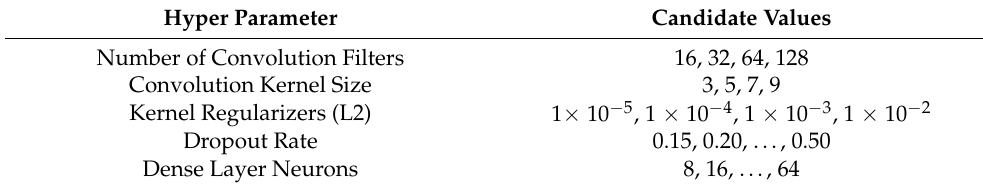
Table 2. Hyperparameter tuning parameters and their candidate